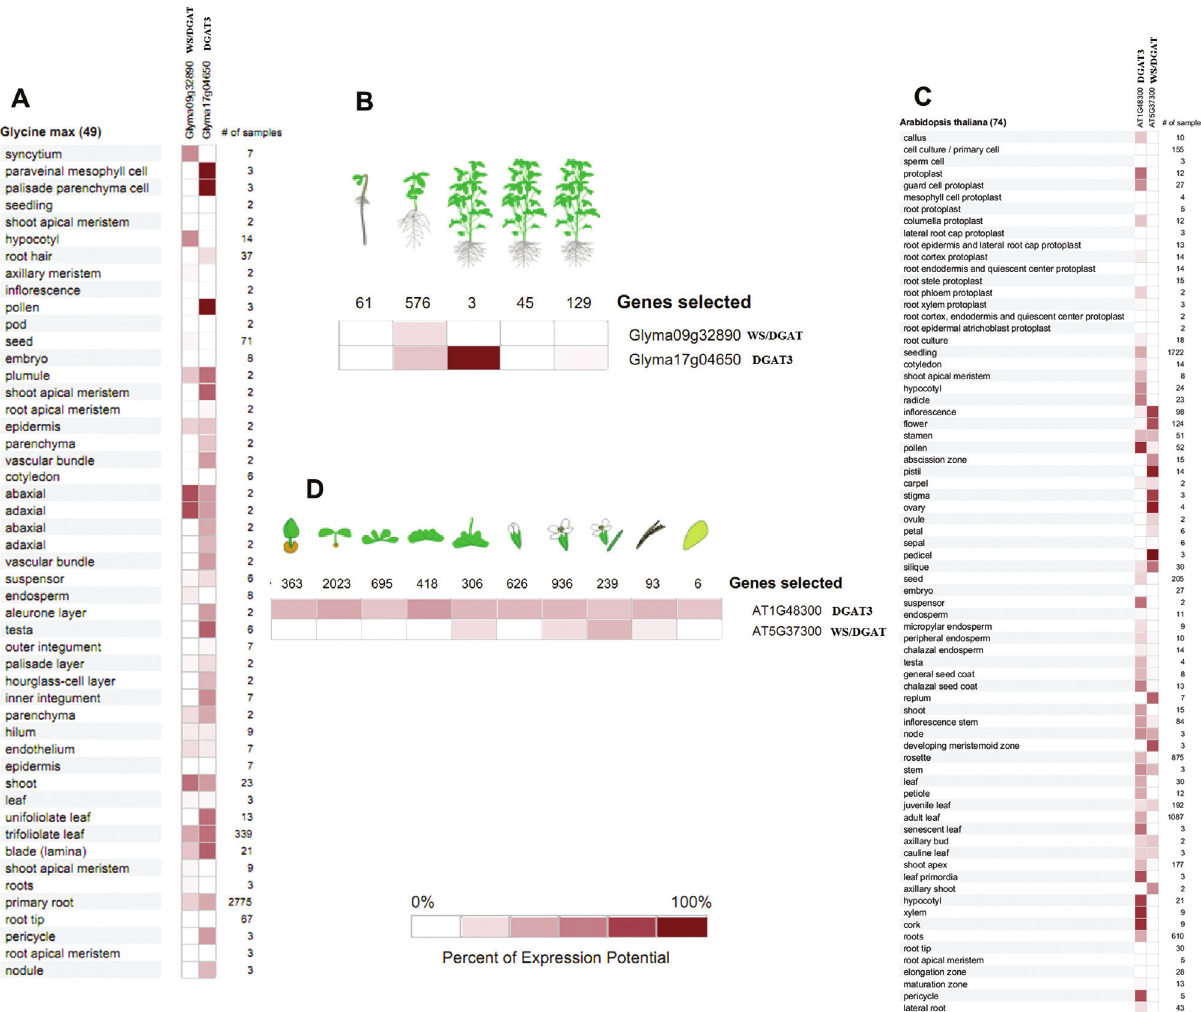
Figure 4 - In silico expression analysis of the selected DGAT genes in soybean and Arabidopsis . The soybean and Arabidopsis DGAT genes were ana- lyzed for organ-specific and developmental expression patterns using the GENEVESTIGATOR program. Expression profile of organ-specific (A) and plant developmental expression profiles (B) of soybean DGAT3 and WS / DGAT genes. Expression profile of organ-specific (C) and plant developmental expression profiles (D) of Arabidopsis DGAT3 and WS / DGAT